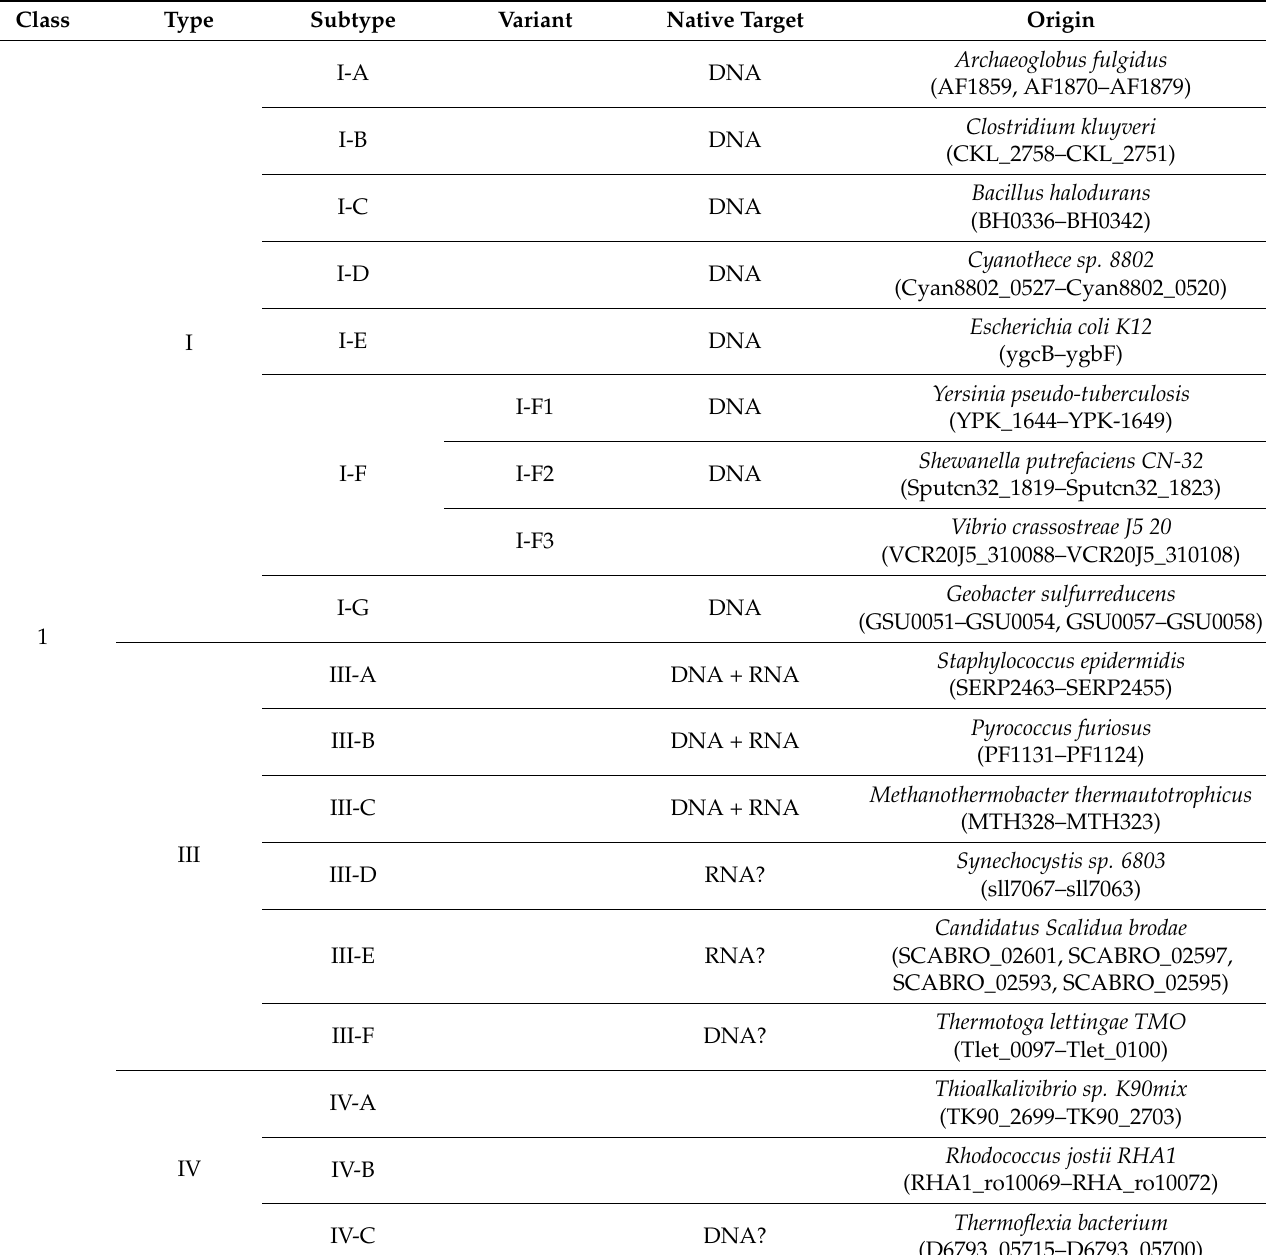
Table 3. Classification of class 1 CRISPR–Cas systems